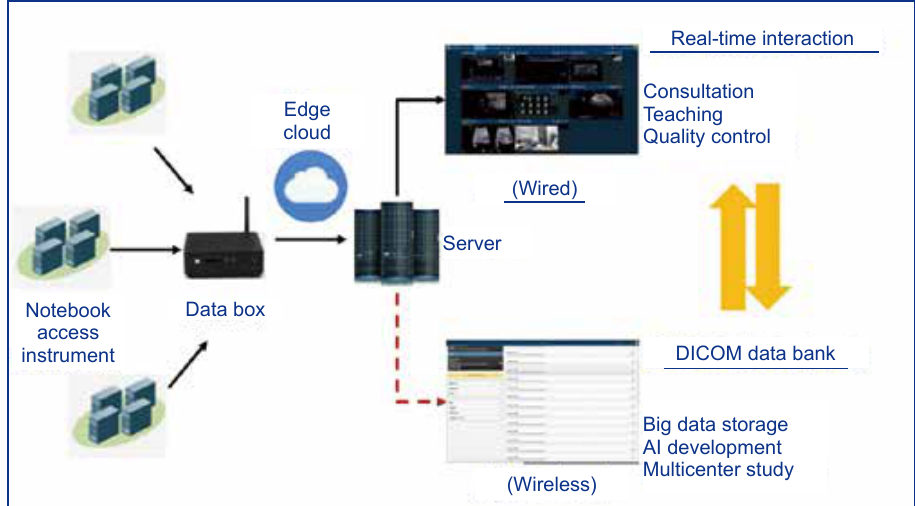
Figure 4 Cloud-based data transmission and management mode: It can provide powerful network services to support the real-time interaction of Digital Imaging and Communications in Medicine (DICOM) data and to ensure the high definition of ultrasound images and the integrity of information; It can also serve as a “DICOM data bank”, providing large shared data sets for wireless ultrasound imaging analysis that offer a great opportunity for the development of artificial intelligence (AI) technology and facilitate high quality data-collecting when performing a multicenter